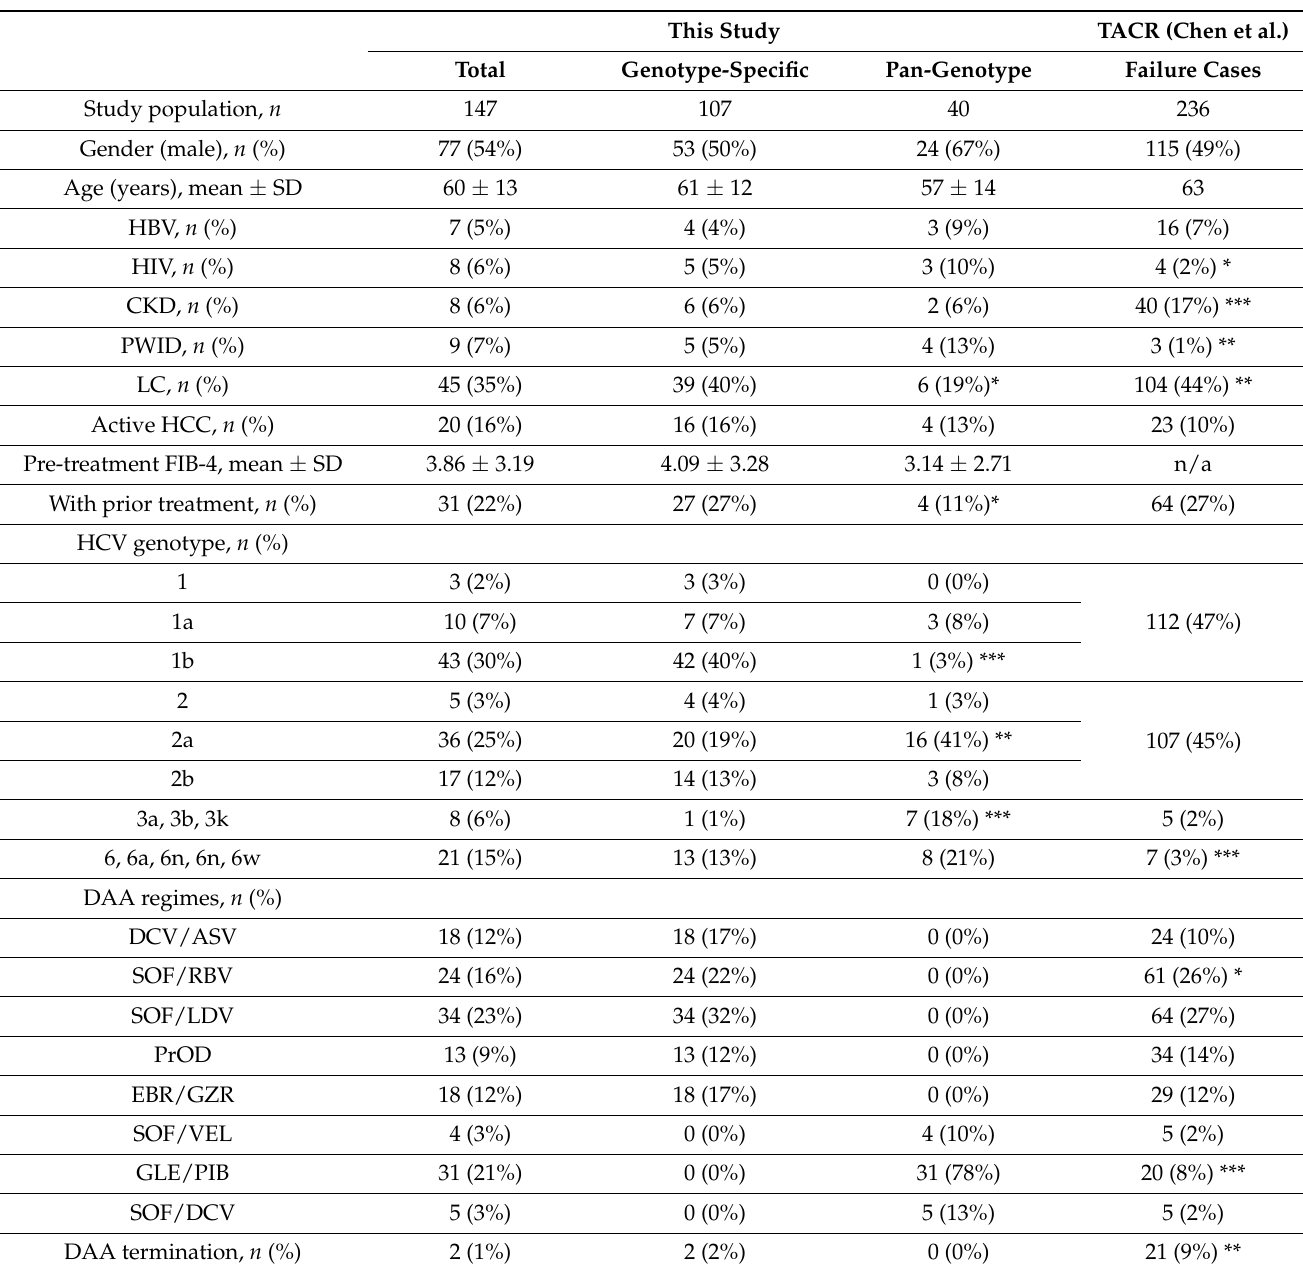
Table 1. Summary of patient characteristics and comparison to TACR DAA treatment failure cases. Statistical comparisons (student t -test) were performed between genotype-specific and pan-genotype casesa and between the study cohort of this study and TACR failure casesb. p -value: *, <0.05; **, <0.01; ***, <0.001. DAA, direct-acting antiviral agents; SOF, Sofosbuvir; DCV, Daclatasvir; LDV, Ledipasvir; PrOD (PTV, Paritaprevir; r, Ritonavir; OBV, Ombitasvir; DSV, Dasabuvir); GZR, Grazoprevir; GLE, Glecaprevir; EBR, Elbasvir; PIB, Pibrentasvir; VEL, Velpatasvir; RBV, Ribavirin; ASV, Asunaprevir. HBV, hepatitis B virus; HIV, human immunodeficiency virus; CKD, chronic kidney disease; PWID, People who inject drugs; LC, liver cirrhosis; HCC, hepatocellular carcinoma. TACR, The Taiwan HCV Registry. n/a, not